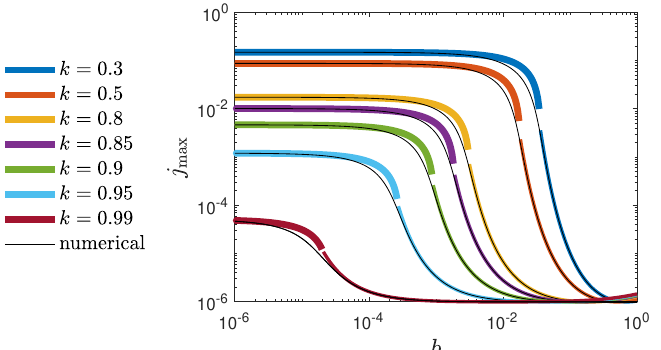
Figure 6. Peak value of the newly infected population fraction j max versus reduced vaccination rate, b , for various k at η = 10 − 6 (double-logarithmic plot). The exact numerical solution (solid black) is compared with the approximant (99) within the regime of b > b c (thin colored), and by the interpolant (101) (thick colored) for the remaining regime of very small b < b c . The limiting value j max ( b → 0 ) exactly coincides with the j SIR max ( k ) of the SIR model (Appendix